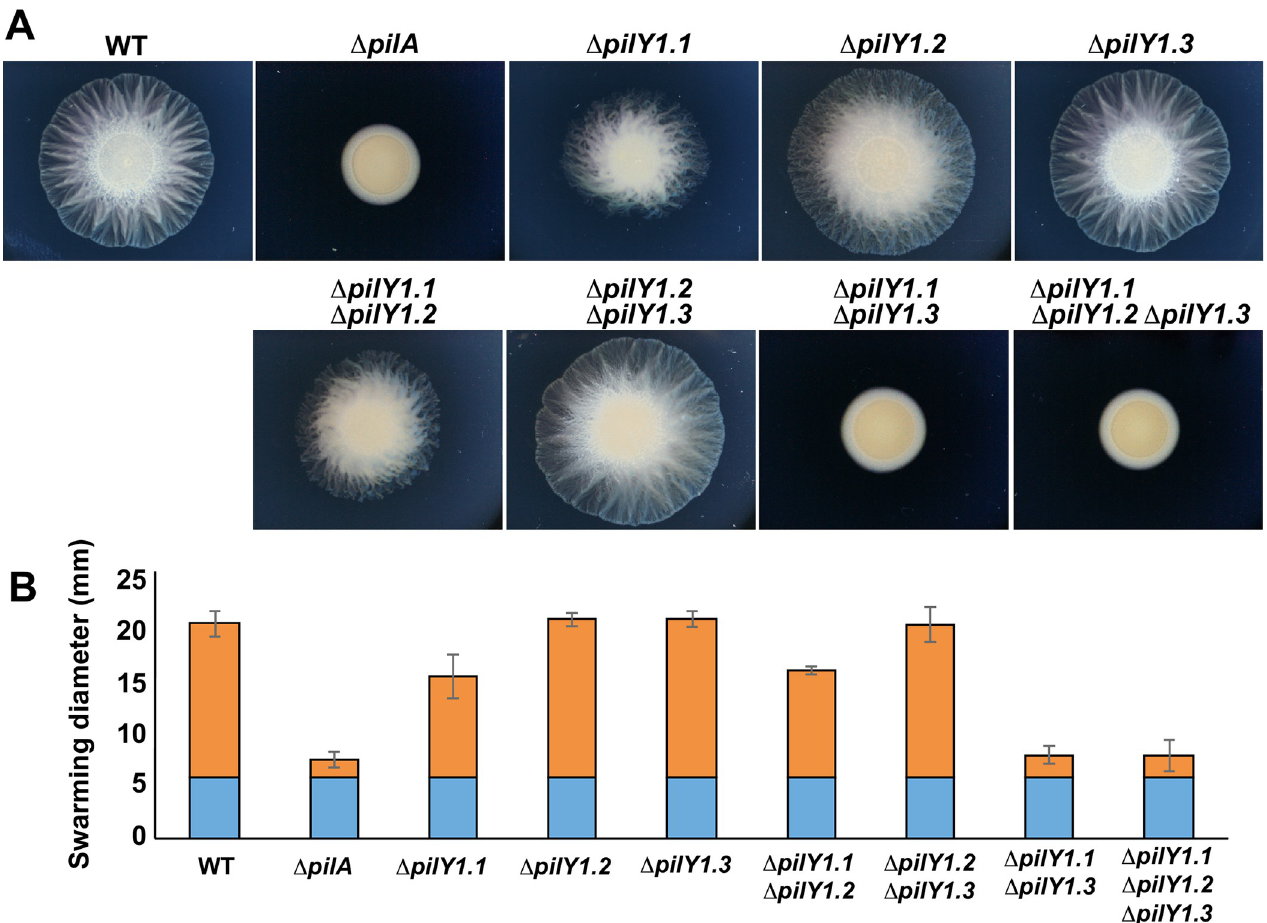
Fig 5. pilY1 . 1 and pilY1 . 3 have functions in twitching motility. (A) Motility phenotypes of DZ2 (wild type), TM389 ( Δ pilA ), EM808 ( Δ pilY1 . 1 ), EM882 ( Δ pilY1 . 2 ), EM856 ( Δ pilY1 . 3 ), EM879 ( Δ pilY1 . 1 Δ pilY1 . 2 ), EM880 ( Δ pilY1 . 2 Δ pilY1 . 3 ), EM857 ( Δ pilY1 . 1 Δ pilY1 . 3 ) and EM881 ( Δ pilY1 . 1 Δ pilY1 . 2 Δ pilY1 . 3 ) on 0.5% agar and imaged at 48H. T4P-motile strains generate flares at the colony edge while non-motile strains form smooth-edged colonies. (B) Diameters of colonies of strains shown in (A). For each strain, the mean value of 3 biological replicates is plotted. Blue bar shows the diameters of the initial spots. Orange bar shows the swarm spreading. Raw data are available in S4